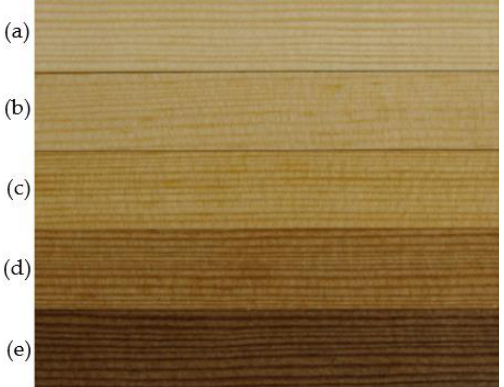
Figure 2. Sample surface—control ( a ) and modified wood (constant modification time—4 h) at a temperature of 130 °C ( b ); 160 °C ( c ); 190 °C ( d ); 220 °C ( e ).